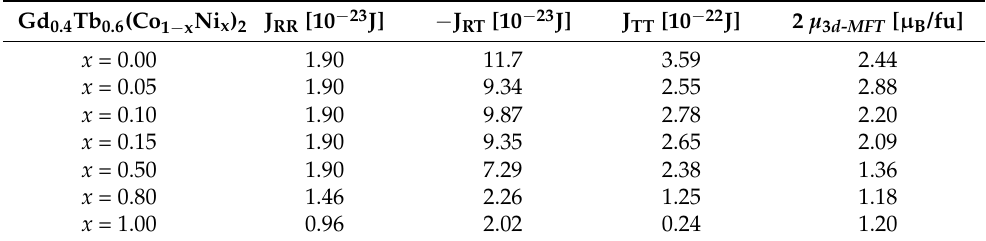
Table 2. The exchange integrals J RR , J RT , J TT , and magnetic moments of the 3 d sublattice calculated in the framework of MFT theory (2 µ 3 d-MFT